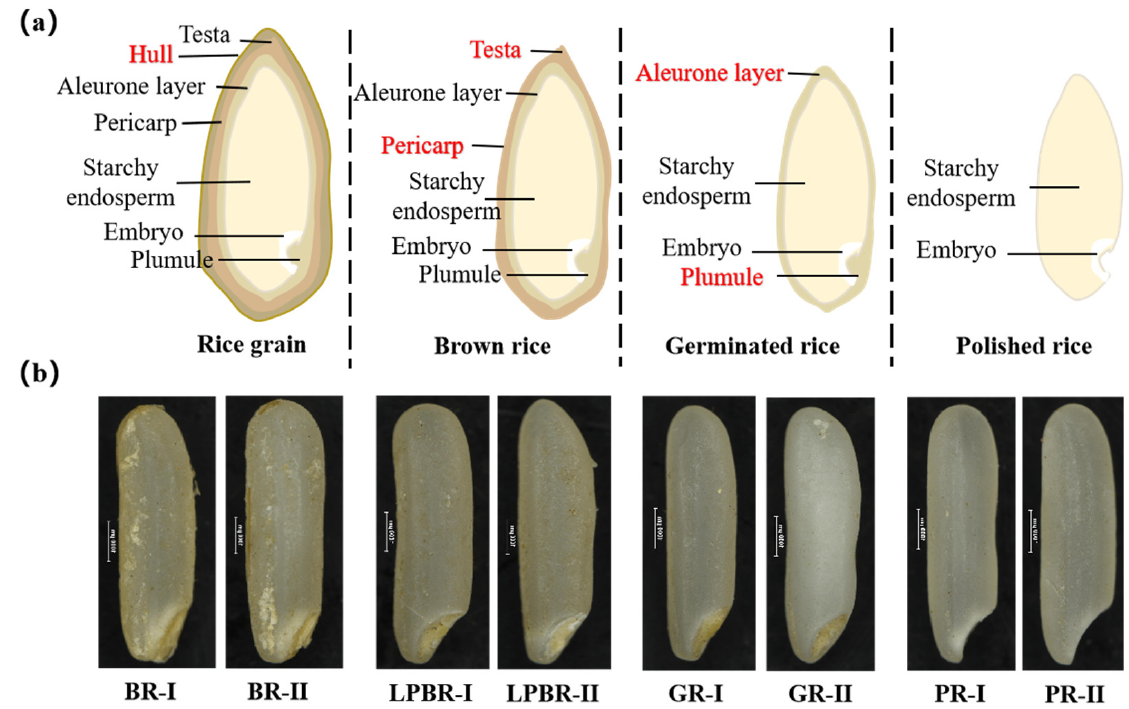
Figure 1. ( a ) Internal structure of mature rice grain and rice with different polishing degrees; ( b ) surface morphology of rice with four degrees of polishing. BR, brown rice; LPBR, lightly processed brown rice; GR, germinated rice; PR, polished rice. I and II indicate the two parallel processing for each polishing degree. The scale bar shown in the Figure 1b is 1000 μ m.